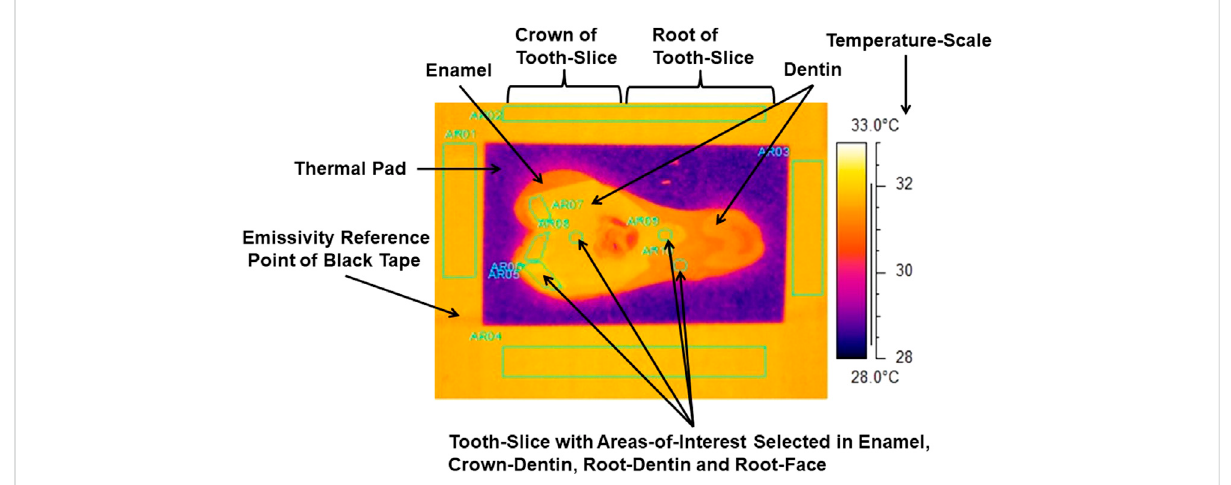
FIGURE 3 Thermograph with areas-of-interest selected in internal enamel, crown-dentin, root-dentin and root-face of a slice of tooth. Emissivity- reference-point provided by 3M Scotch Super 33+ Black Vinyl Electrical Tape.